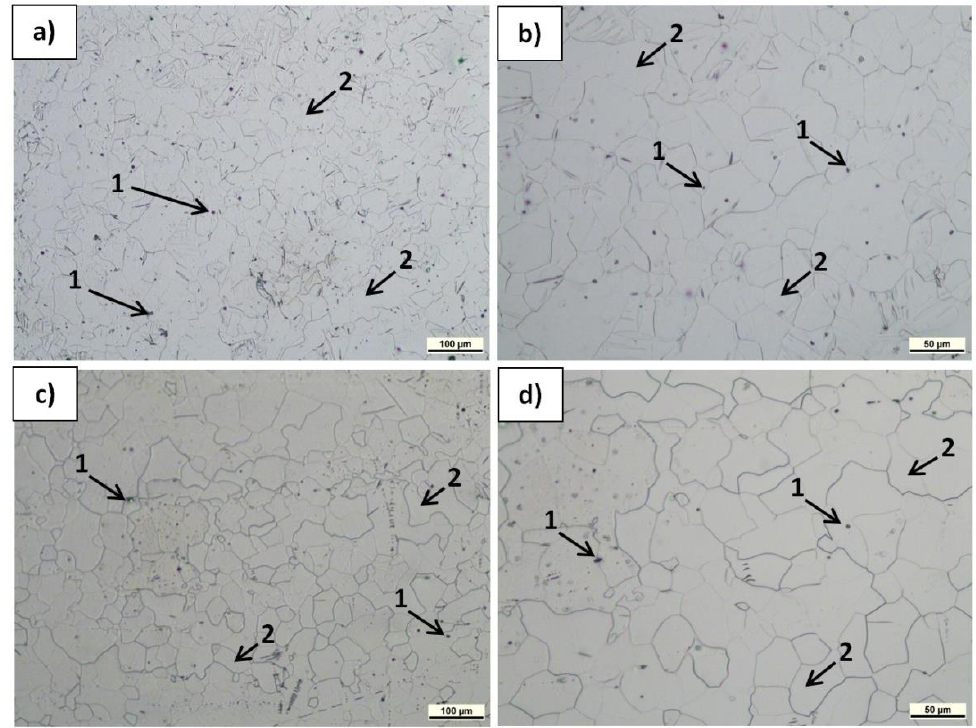
Figure 8. LM micrographs of etched transverse ( a,b ) and longitudinal ( c,d ) sections of Mg(C) rod KOBO-extruded: 1 — single MgO particles, 2 —α -Mg grains.